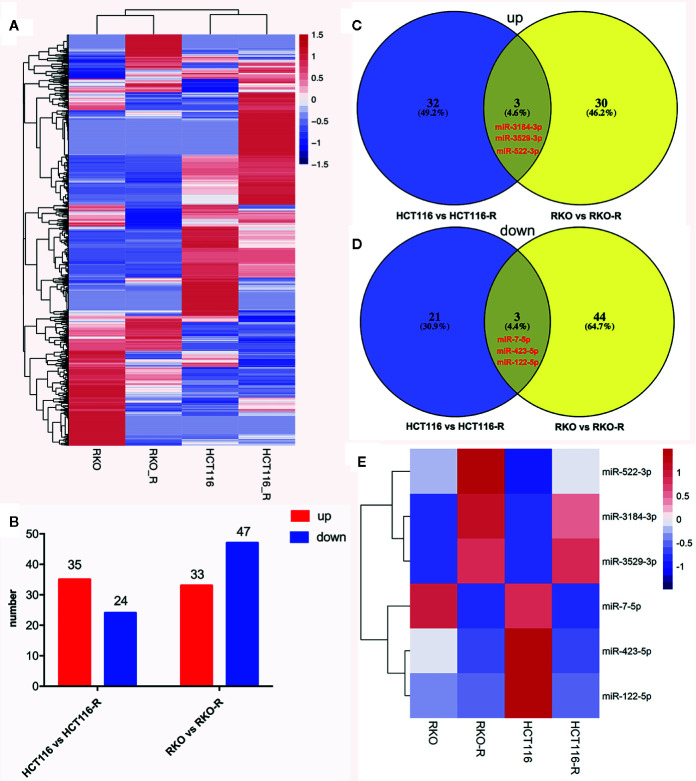
miRNA expression signature in the radioresistant colorectal cancer cells as compared to parental cells. (A) The heatmap from the hierarchical clustering of 1,559 miRNAs expression patterns in the four colorectal cancer cell lines was shown. (B) The number of differentially expressed miRNAs (DEMIs) between HCT116 compared to HCT116-R, and RKO compared to RKO-R, were analyzed. (C, D) The Venn diagrams display the six DEMIs by taking the intersection of the DEMIs between acquired radioresistant and parental colorectal cancer cells, including three upregulated miRNAs (miRNA-3184-3p, miRNA-3529-3p and miRNA-522-3p) and three downregulated miRNAs (miRNA-7-5p, miRNA-423-5p and miRNA-122-5p) in radioresistant cells. (E) The heatmap displays the expression patterns of the six DEMIs.